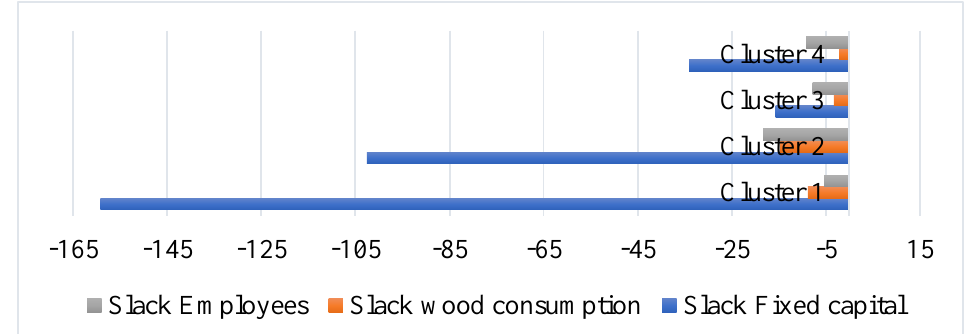
Figure 5. Dendrogram reflecting clusters of sustainability models. Source: authors’ projection.